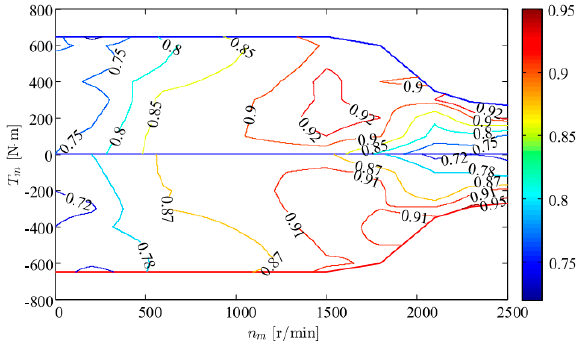
Figure 3. Motor efficiency map. Figure 3. Motor e ffi ciency